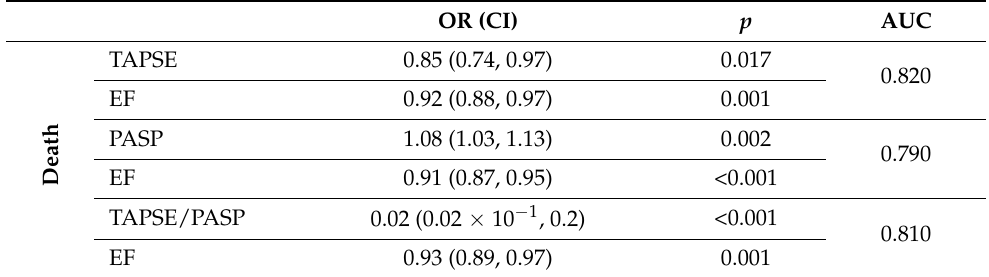
Table 3. Weighted multivariable logistic regression